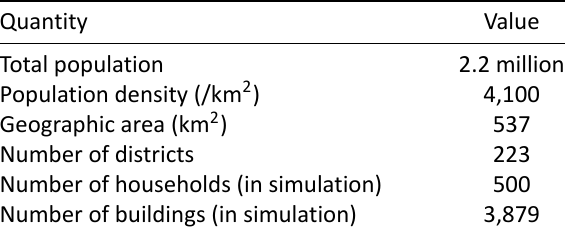
Table 1. Summary statistics of Greater Beirut